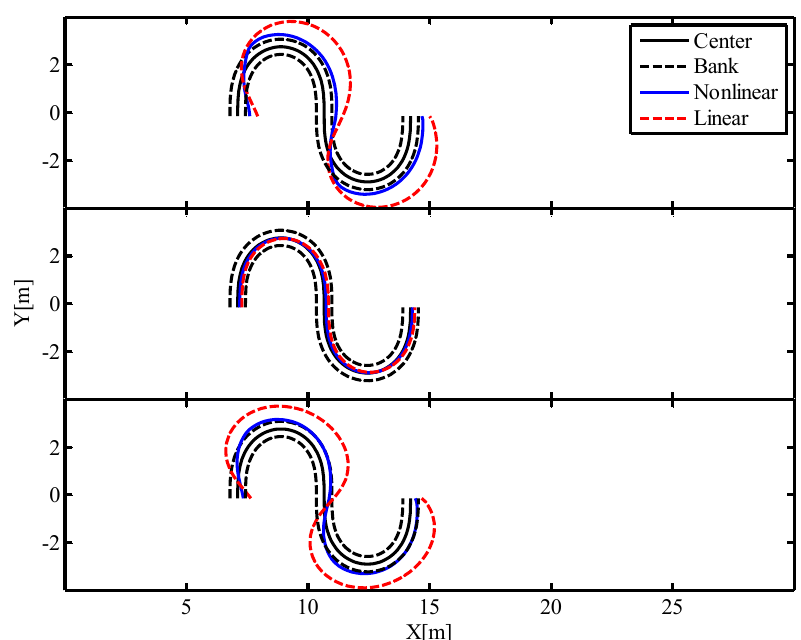
Figure 8. Comparison of the linear and nonlinear RHS terms ( top ); the difference between the discharge bisector lines and the original channel centerlines ( middle ); and the new channel centerlines after 8 hours of migration ( bottom ) computed by the nonlinear and linear models in the θ 0 = 90° case.